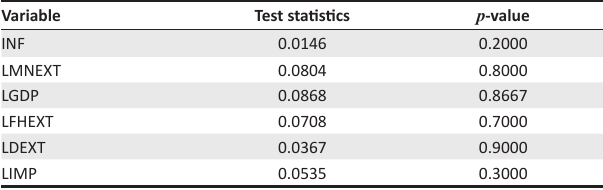
TABLE 5: Breitung non-linear unit root. Variable Test statistics